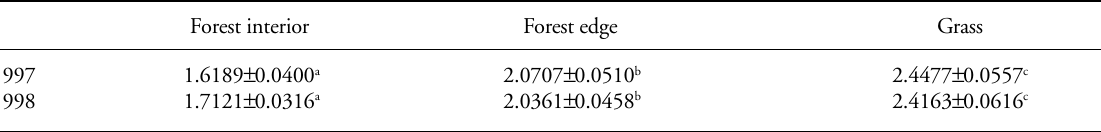
Table 3 . Shannon diversity of carabids (with SD) in the studied habitats. Means with different letters indicate a significant (p<0.05) difference by Hutcheson’s t-test. Forest interior Forest edge